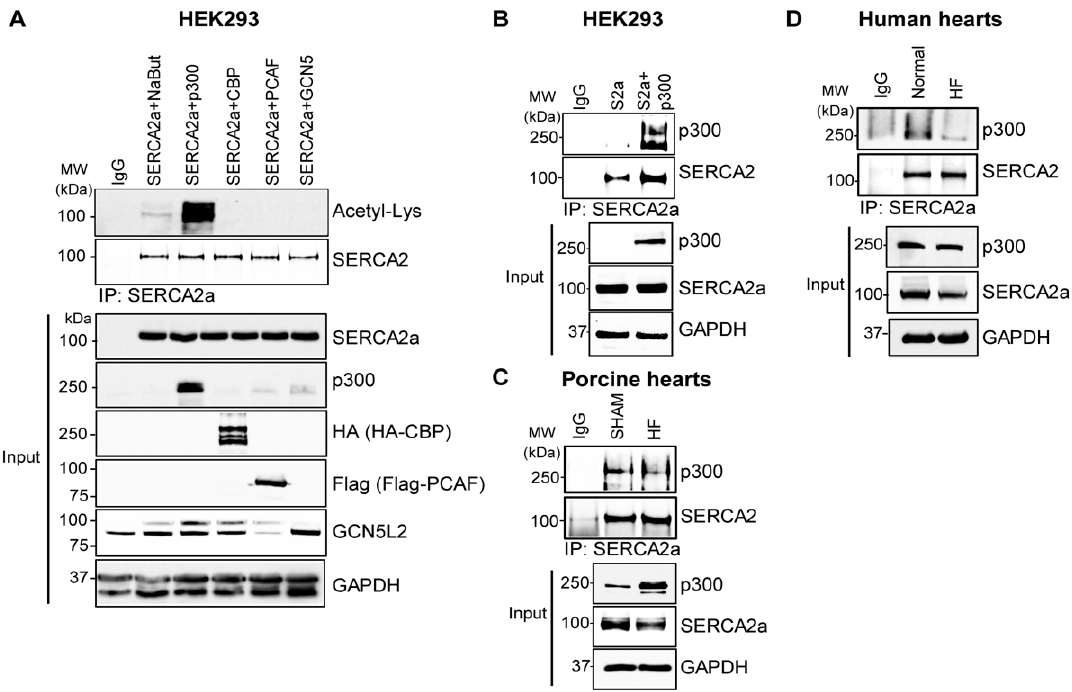
Figure 2. p300 interacts with and acetylates SERCA2a. ( A ) HEK293 cells were transfected with SERCA2a alone or SERCA2a in combination with different acetyltransferases (p300, CBP, PCAF, GCN5). Immunoprecipitated with anti-SERCA2a antibody was conducted with lysates of these HEK293 cells and probed with anti-acetyl-lysine antibody. ( B ) HEK293 cells were transfected with SERCA2a alone or SERCA2a in combination with p300. Immunoprecipitated with anti-SERCA2a antibody was conducted with lysates of these HEK293 cells and probed with anti-P300 antibody. ( C ) Immunoprecipitation of SERCA2a from sham-operated and myocardial infarction-induced heart failure pig hearts showing the interaction between SERCA2a and p300. ( D ) Immunoprecipitation of SERCA2a from normal and heart failure human patient hearts showing the interaction between SERCA2a and p300.